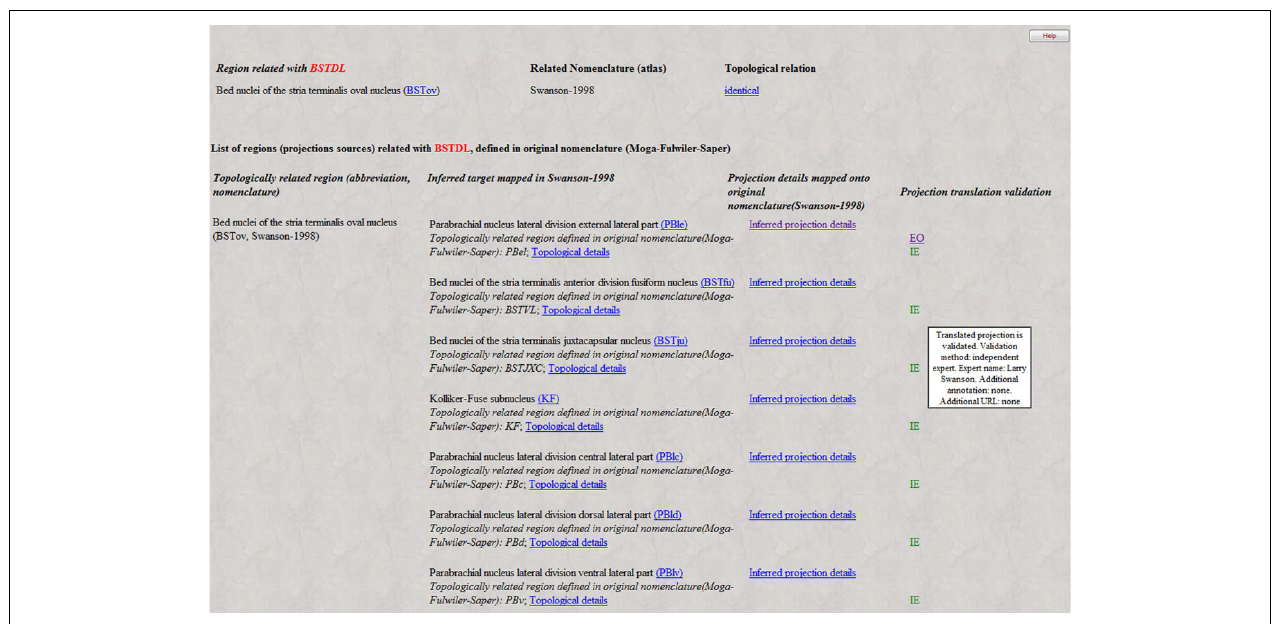
FIGURE 8 | Example of validation of the process of neuroanatomical projections translation. A portion of the projections pattern of BSTDL (Moga–Fulwiler–Saper nomenclature), which is the result of translation of